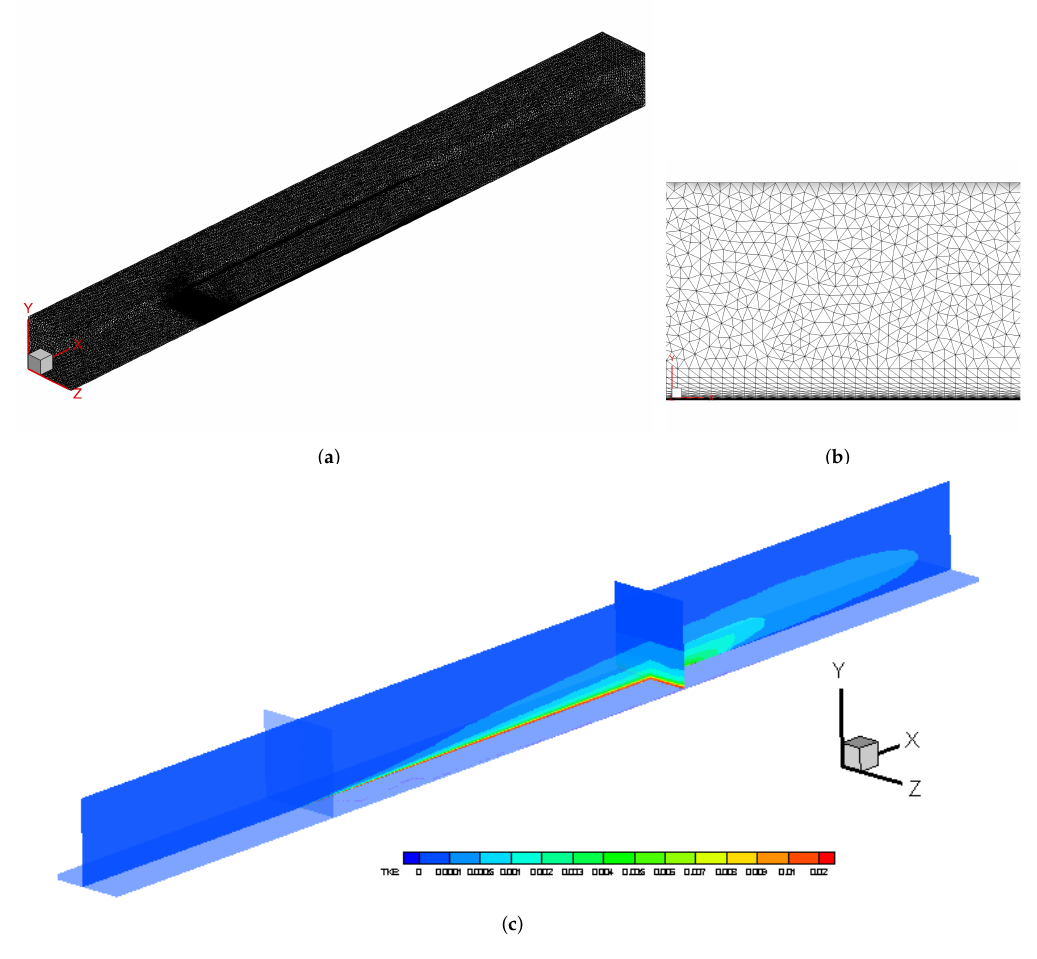
Figure 1. Mesh schematic ( a ); close-up of the near wall region ( b ); and iso-contours of turbulent kinetic energy from Menter SST ( c ) in the supersonic flat plate.